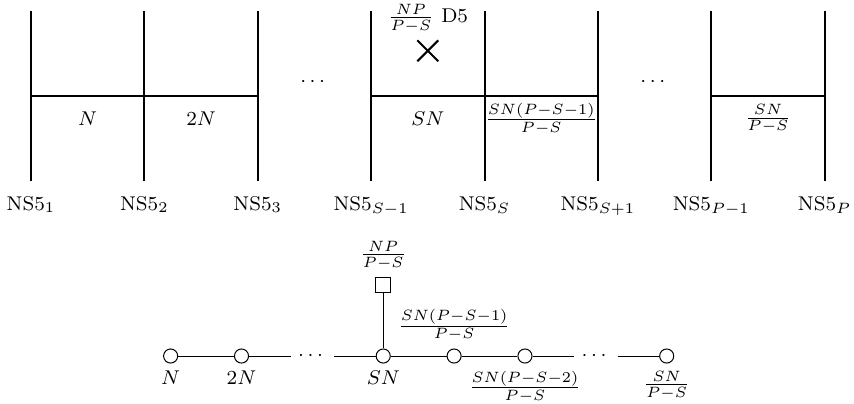
Figure 2 . The Hanany-Witten and quiver associated with a generic triangular rank function. As usual, vertical lines represent NS-five branes. Horizontal lines and circular nodes denote D3 branes and crosses and square nodes indicate D5